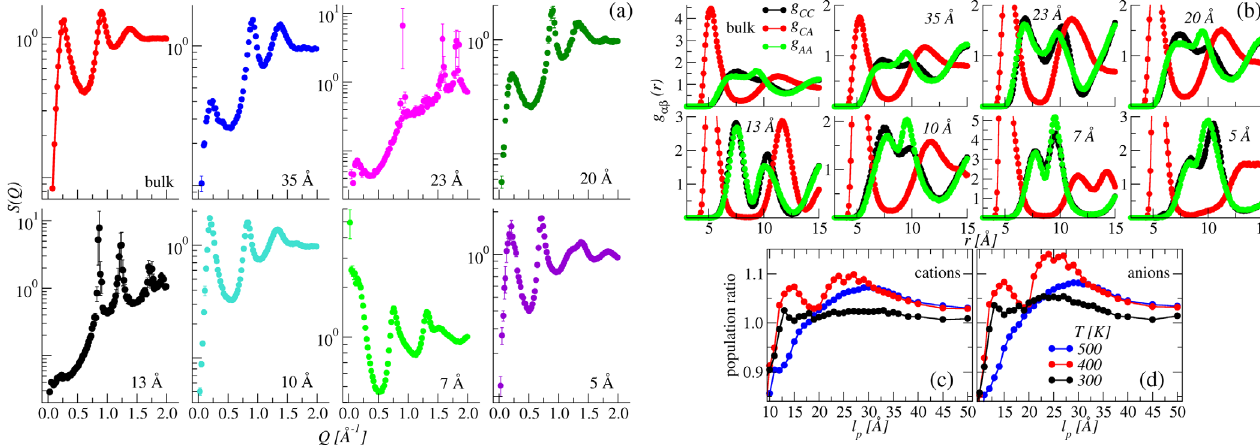
FIG. 3. Details of the static structure and coordination properties. (a) Static structure factors S ð Q Þ in the bulk and at the indicated values of l , at T ¼ 400 K. Data are shown on a logarithmic ( y ) scale. (b) Partial pair distribution functions g p and at the indicated values of l . (c),(d) l dependence at the indicated temperatures of the fraction of coions in the first coordination p p shell normalized to the value in the bulk, for cations and anions,